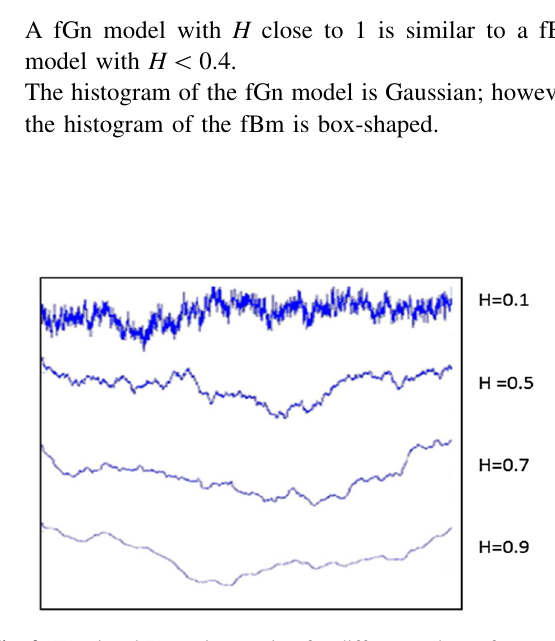
Fig. 2 Fractional Brownian motion for different values of